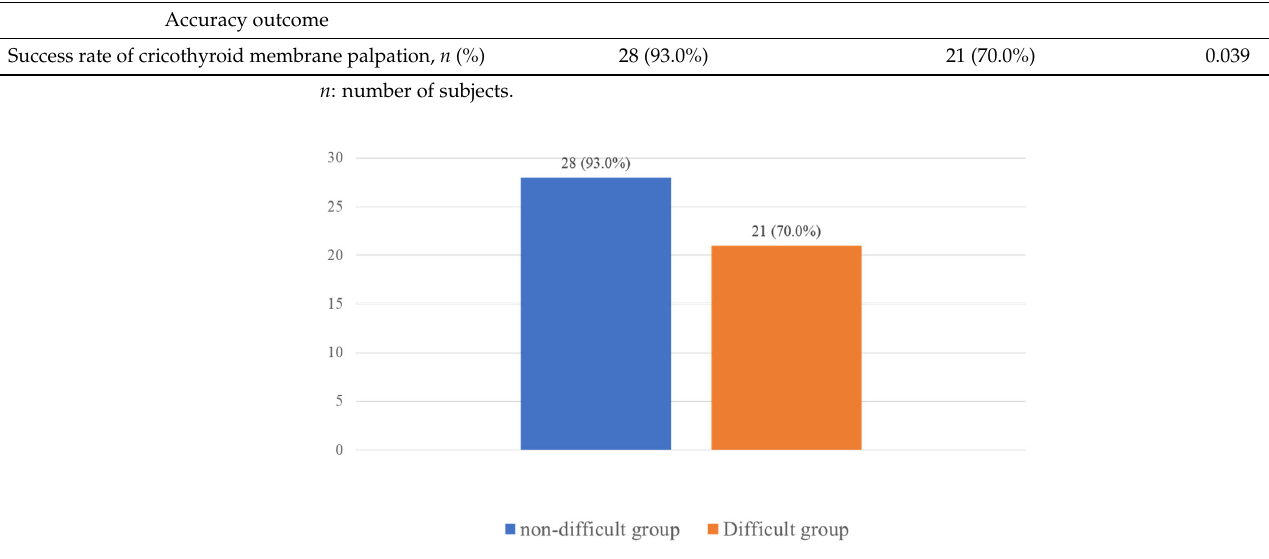
Figure 6. Success rate of cricothyroid membrane palpation. Table 2. Accuracy of cricothyroid membrane palpation according to the 3 ‐ 3 ‐ 2 rule for predicting difficult airway in female patients undergoing non ‐ neck surgery.